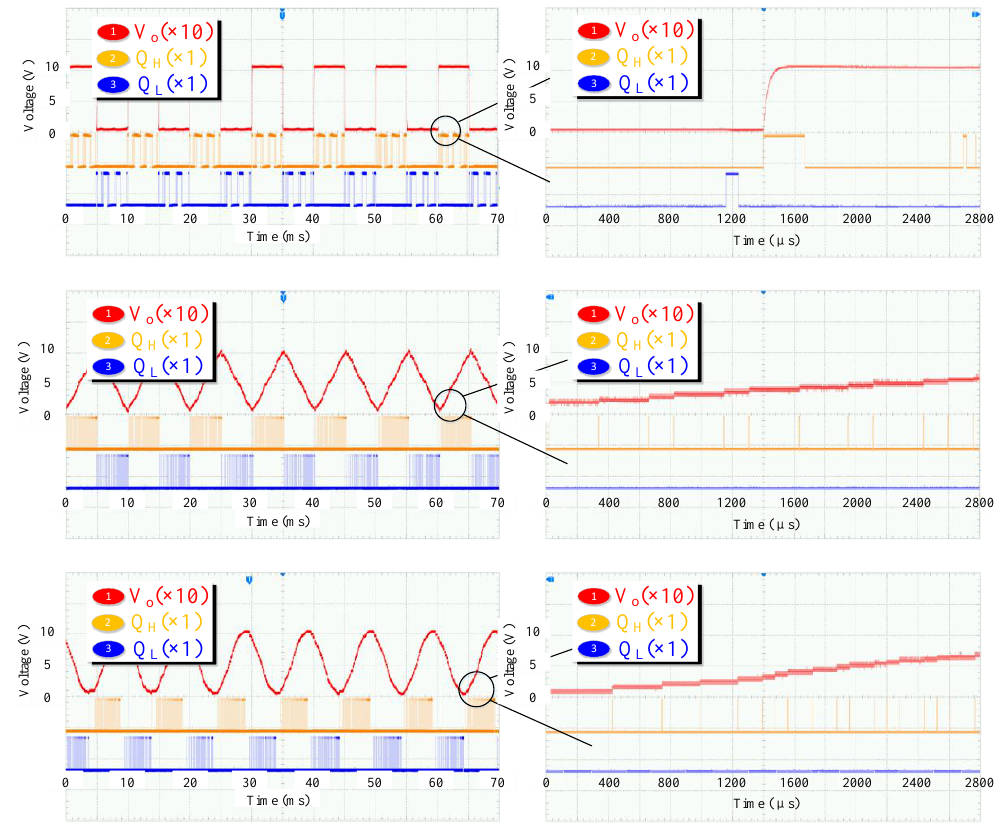
Figure 14. Images of the control pulses and output waveforms.